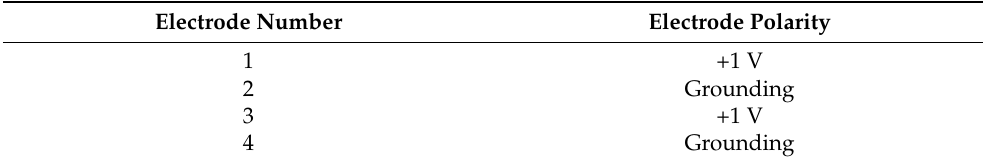
Table 5. Electrode polarity of IDT in simulation